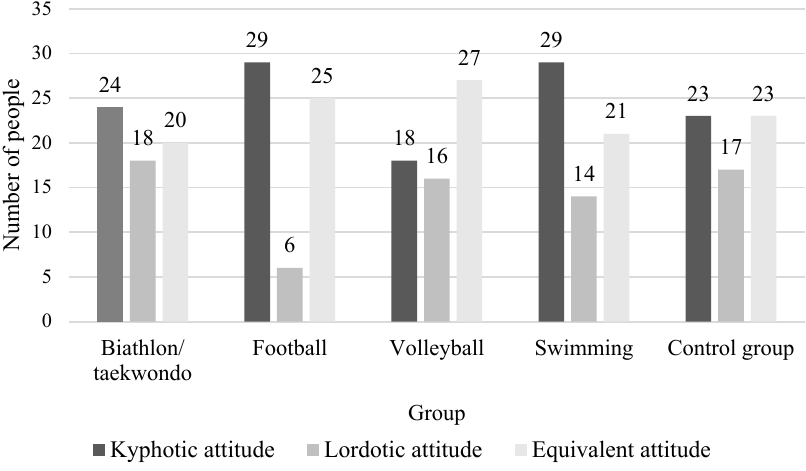
Figure 3. Types of body posture in the studied groups .